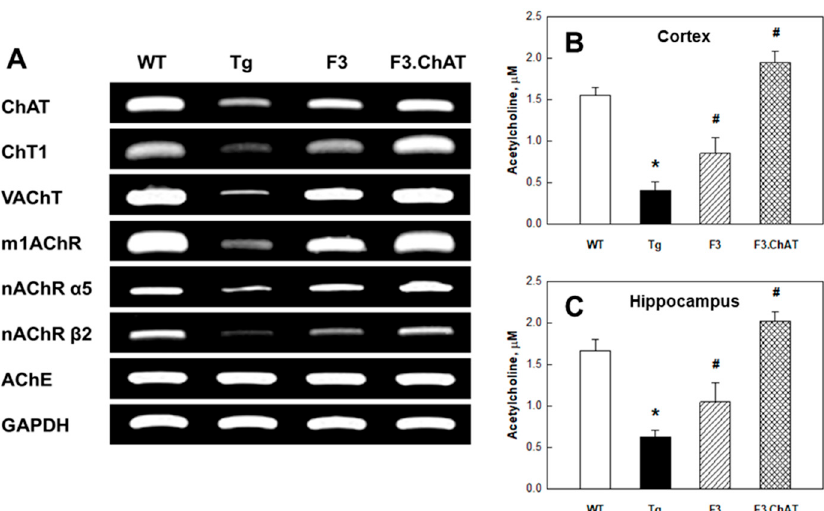
Figure 2. Cholinergic nervous system markers and acetylcholine concentration in the mouse brain. ( A ): Cholinergic nervous system markers. ( B , C ): Acetylcholine concentration in the cortex (B) and hippocampus (C) of wild-type (WT) and APPswe/PS1dE9 transgenic (Tg) mice transplanted with F3 or F3.ChAT neural stem cells. * Significantly different from WT mice ( p < 0.05). # Significantly different from Tg mice ( p < 0.05).